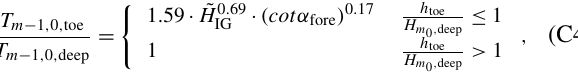
(cid:40) 1 . 59 · ˜ H 0 . 69 =